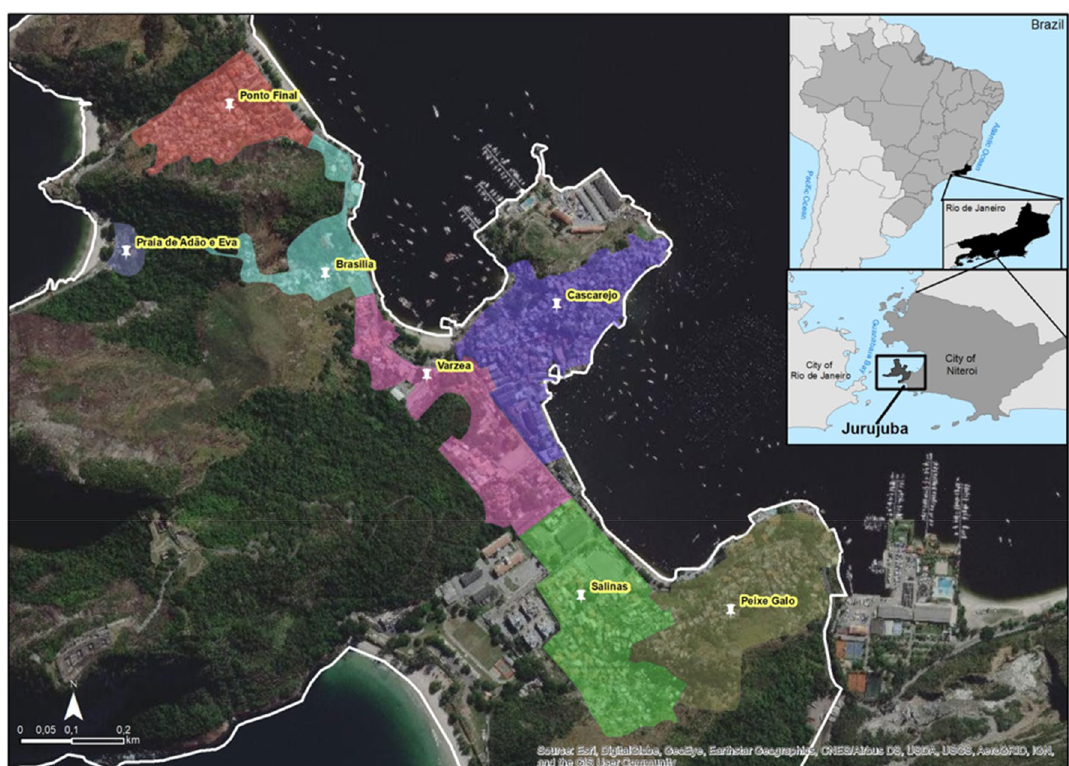
Figure 1. Map of Jurujuba release areas. Satellite view of Jurujuba, a suburban neighborhood of Niterói (RJ). With an estimated population of 2797 in 2.53 km 2 , Jurujuba was divided into seven release areas (highlighted) according to local sectors: Ponto Final, Várzea, Brasília, Cascarejo, Praia de Adão e Eva, Peixe-Galo and Salinas. Map was created with ArcGIS Desktop 10.7 (Esri Inc., https:// www. esri. com/ en- us/ arcgis/ produ cts/ arcgis-